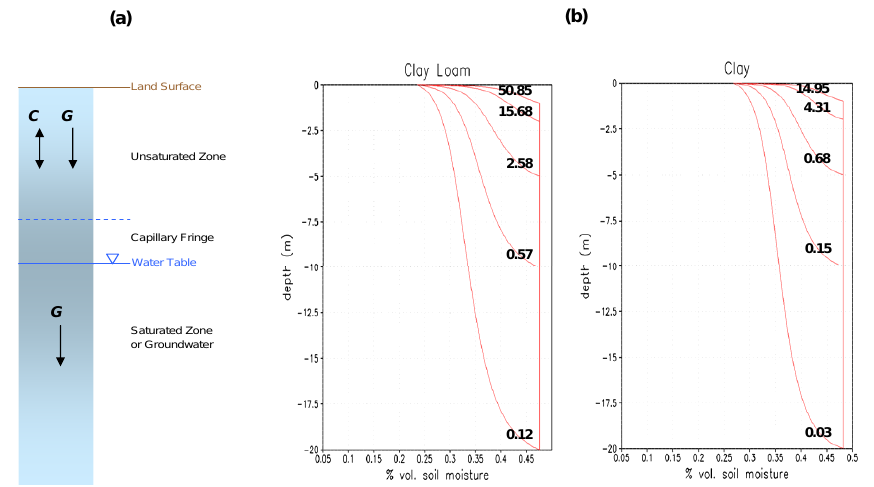
Fig. 12. (a) Typical soil water zones. Upward and downward capillary fluxes ( C ) and downward gravity flux ( G ) drive soil water movement above the water table, and gravity ( G ) drives the flow below the water table. (b) Theoretical soil moisture profile and upward capillary flux (mm day -1 ) calculated from the Richards Equation, with wilting point prescribed in the top 0.05 m and saturation at the water table at various depths (1, 2, 5, 10, and 20 m), for the two most abundant soil types in the Amazon (clay-loam and clay). These fluxes represent the potential or maximum strength of the capillary force.